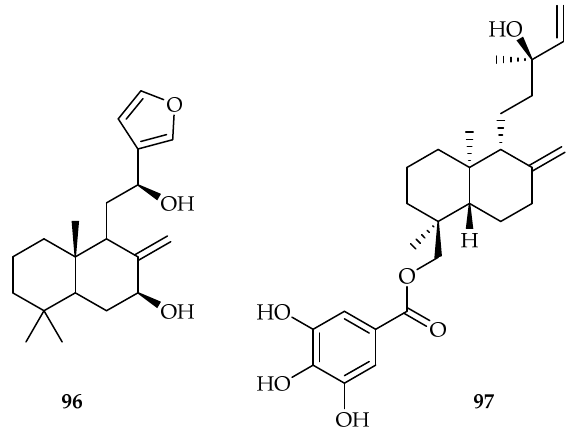
Figure 39. Structure of coronarin K 96 [60] and euphodane A 97 [61].